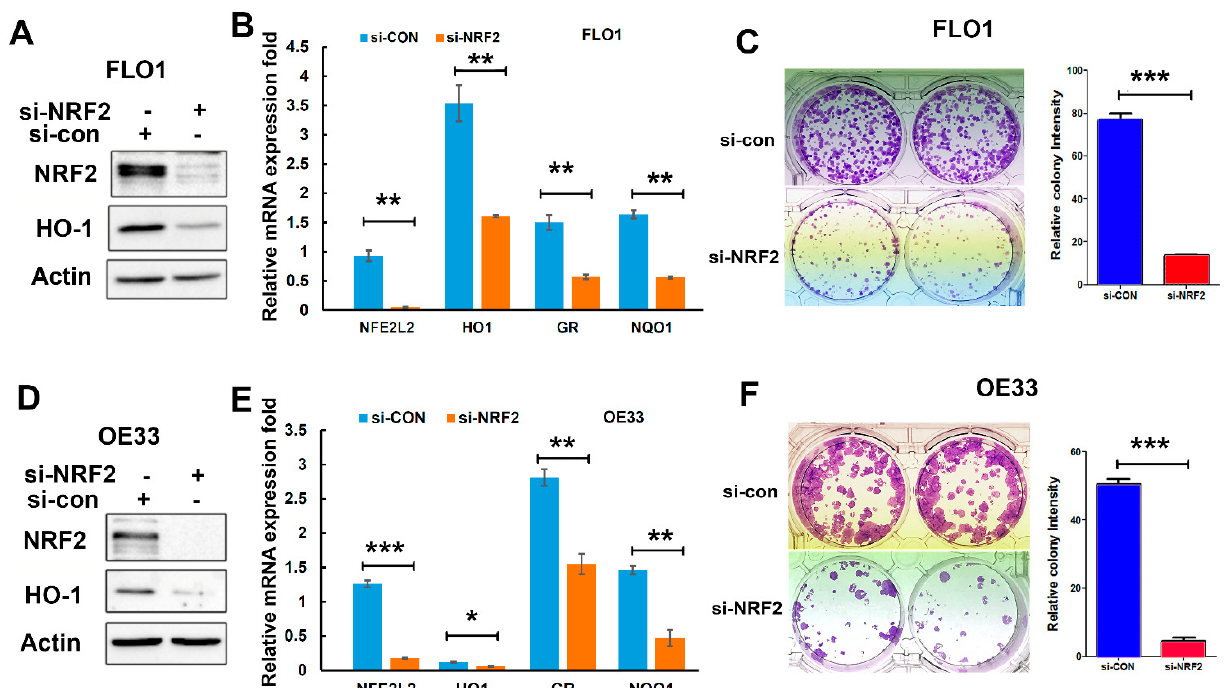
Figure 3. Knockdown of NRF2 inhibited EAC cell growth in vitro. ( A , D ) Western blotting indicates protein levels of NRF2 and HO1 (an NRF2 target gene) after NRF2 knockdown using an NRF2 siRNA in FLO1 ( A ) and OE33 ( D ) cells. ( B , E ) Real-time qPCR shows the downregulation of NRF2 target genes (HO1, GR, and NQO1) in FLO1 ( B ) and OE33 ( E ) cells after NRF2 knockdown. ( C , F ) The colony formation assay demonstrated significantly fewer and smaller colonies after NRF2 knockdown in FLO1 cells ( C ) and OE33 cells ( F ). * p < 0.05; ** p < 0.01; *** p < 0.001.